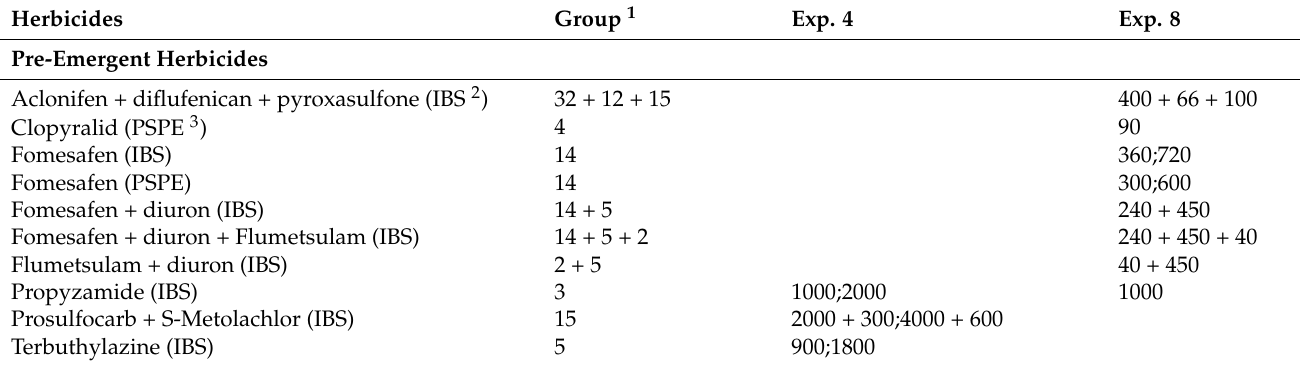
Table 4. Rates of active ingredient (a.i.) g/ha used in experiments 4 and 8 with pre-emergent herbicides.